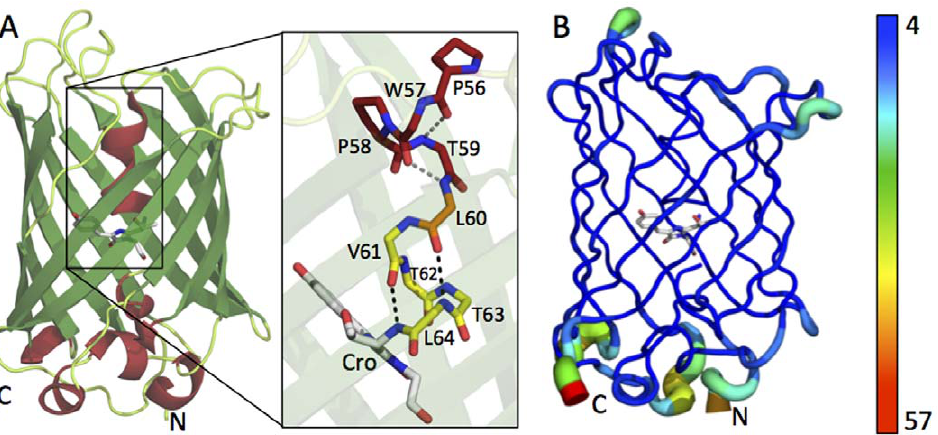
Figure 1. Structure of EGFP. (A) Ribbon representation of EGFP highlighting b -strands in green, helices in red and loops in pale green. Inset , Stick representation of the central helix forming residues (main chain only) in the 3 10 conformation (dark red) and in the a conformation (yellow). Residue Leu60 (orange) is involved in hydrogen bonding in the 3 10 portion of the helix (grey dashed lines) and the a portion of the helix (black dashed lines). (B) B-Factor putty representation of EGFP with chromophore shown as sticks. The B-factor color scale is shown to the right. The regions with high B- factors (shown as bulges) are: K3 to G10 (N-terminus); G115 to D116; K131 to G134; A154 to I161; P187 to P196; K209 to E213; G228 to L231 (C- terminus). (Figure 5C) and in the alternate conformation it donates a hydrogen bond to the hydroxyl group of Ser205 (Figure 5D). In